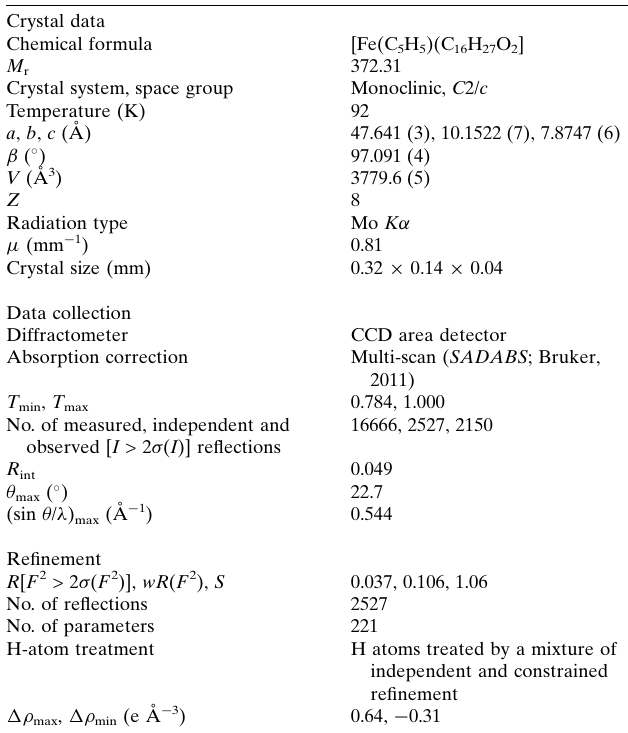
Table 3 Experimental details. Crystal data Chemical